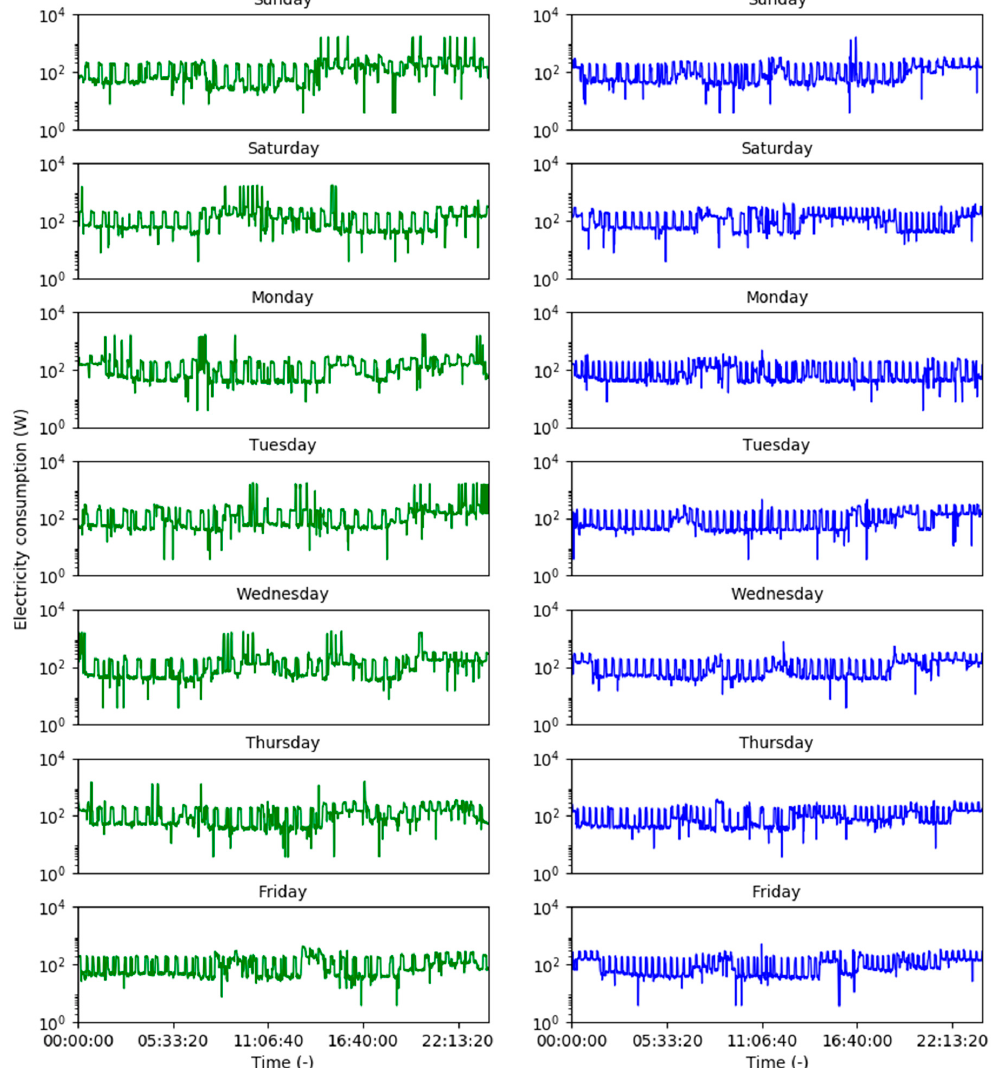
Figure 6. Daily representative electricity demand profile for ‘Home 1’ with air-conditioner (A/C) ((Green) 3–9 November 2018, (Blue) 22–28 December 2018).